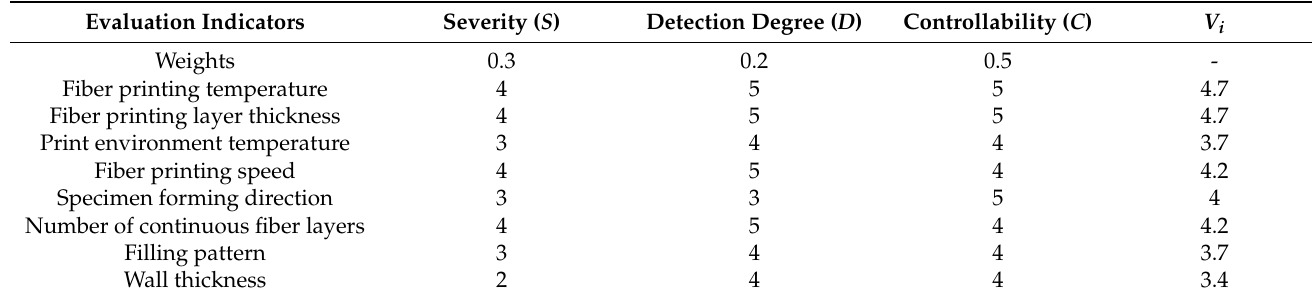
Table 2. Impact factor evaluation correlation matrix table.